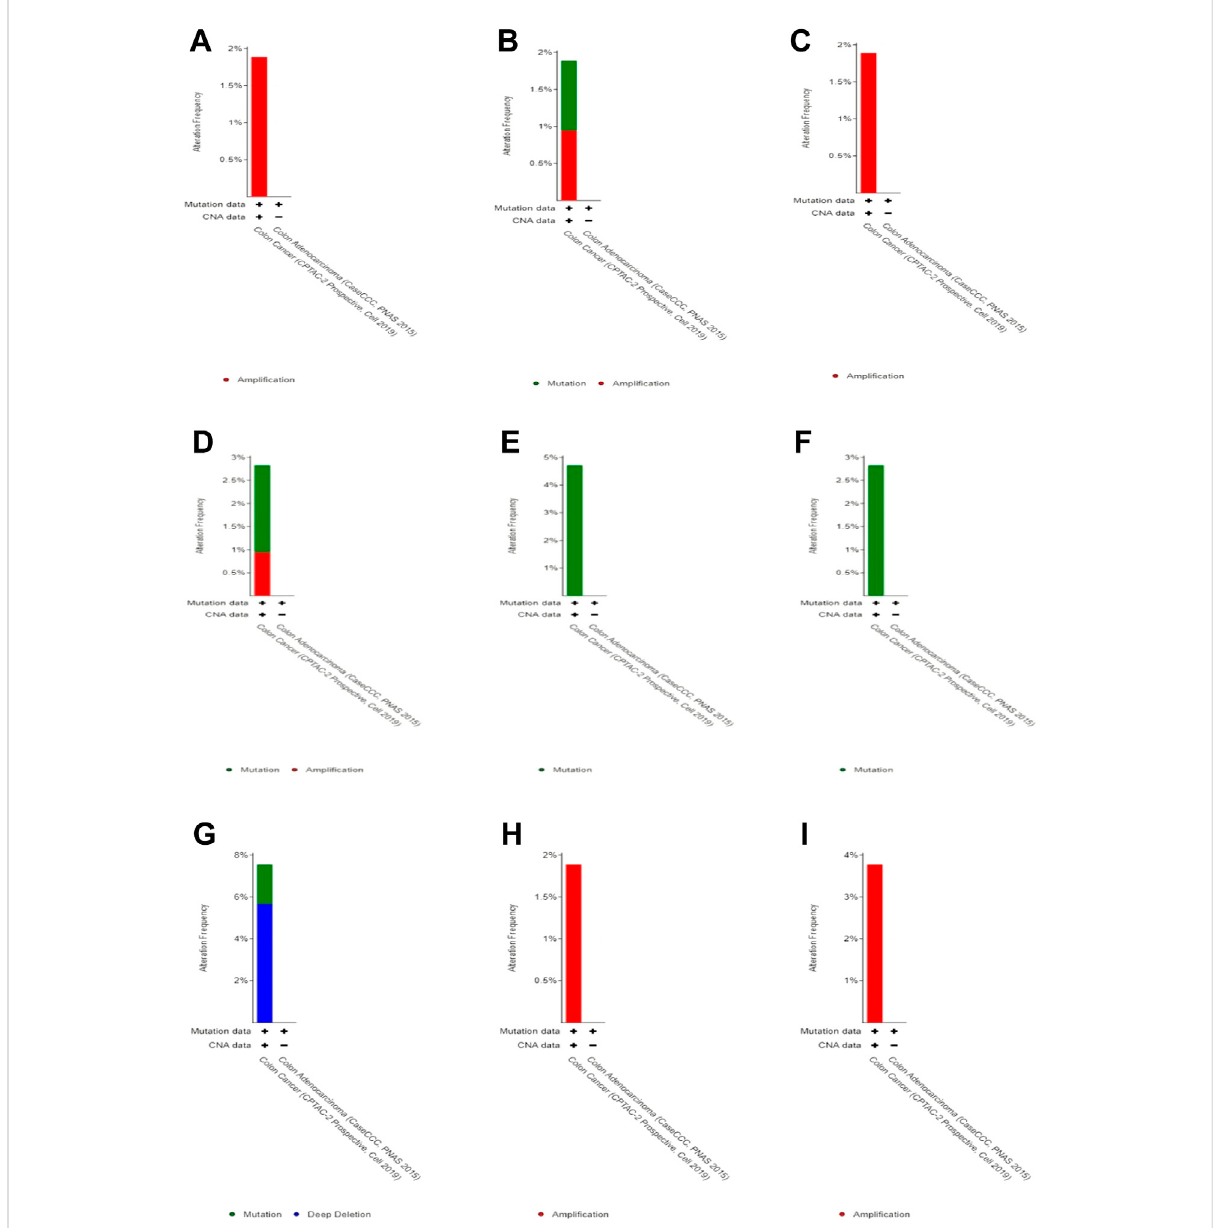
FIGURE 5 Genomic alteration in DEGs. (A) CLC, (B) ZG16, (C) LRRC26, (D) ITLN1, (E) B3GNT6, (F) CLCA1, (G) GFI1, (H) HEPACAM2, and (I)